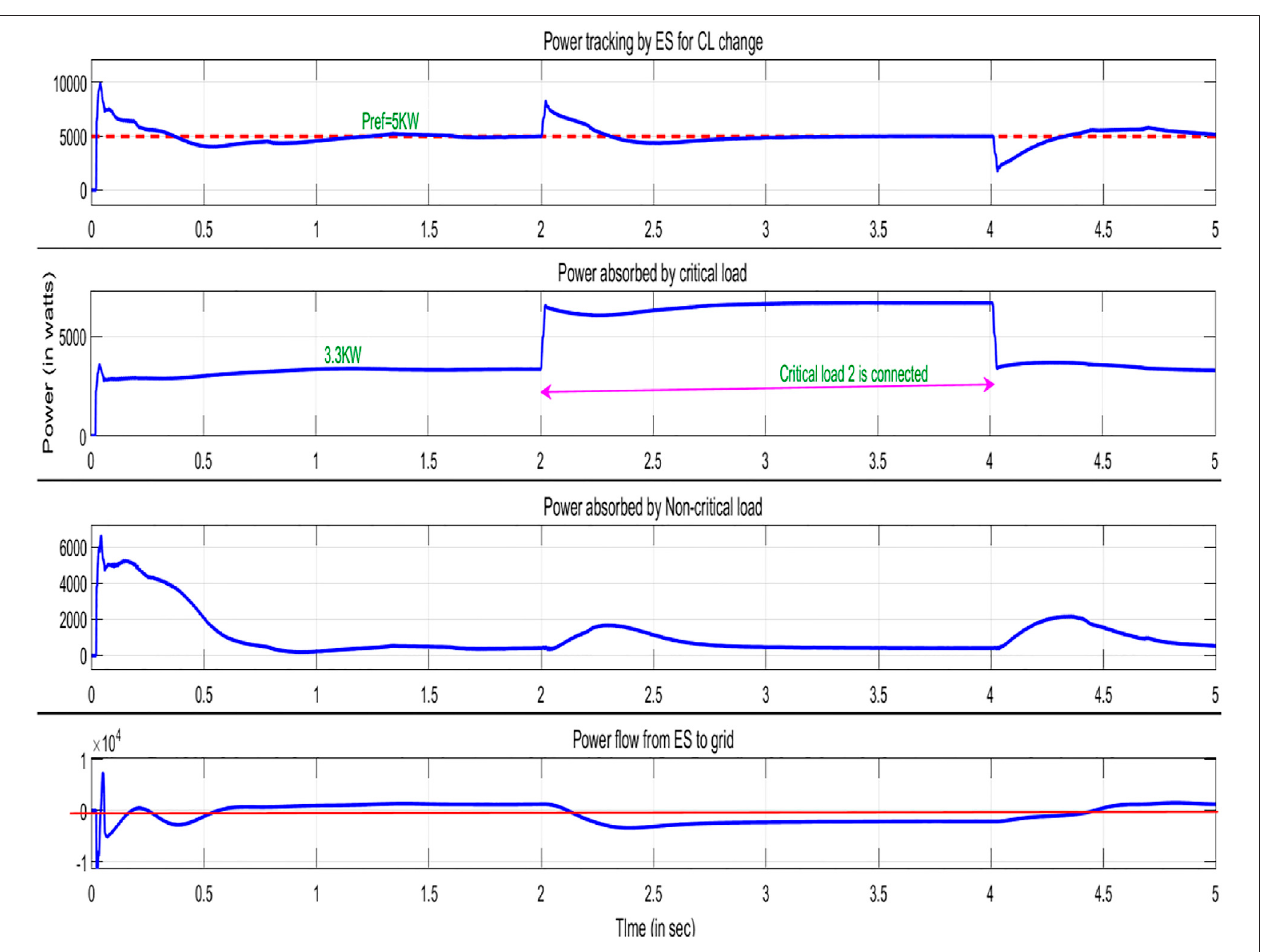
FIGURE 11 | Performance for change in critical load and P ref = 5